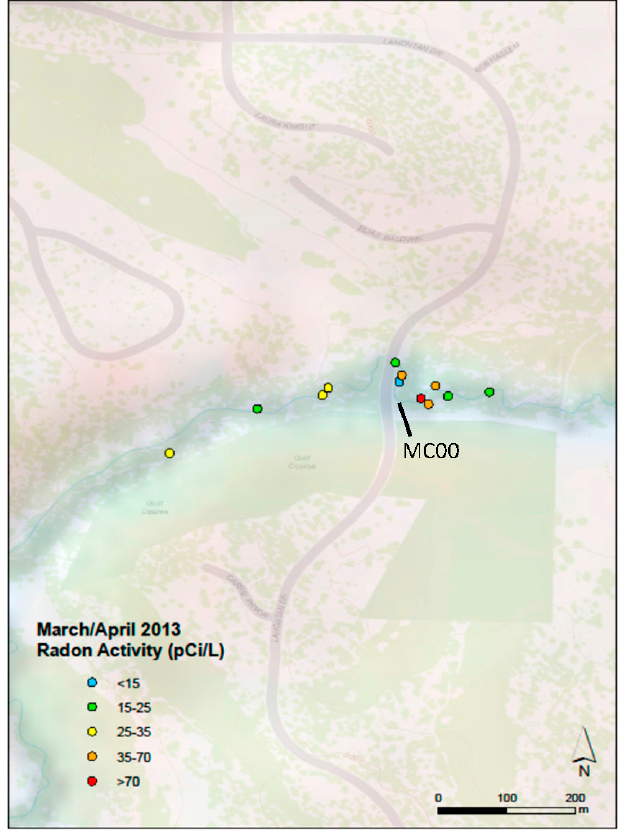
Figure A3. Results of March/April 2013 Radon survey, also shown in Table A2.